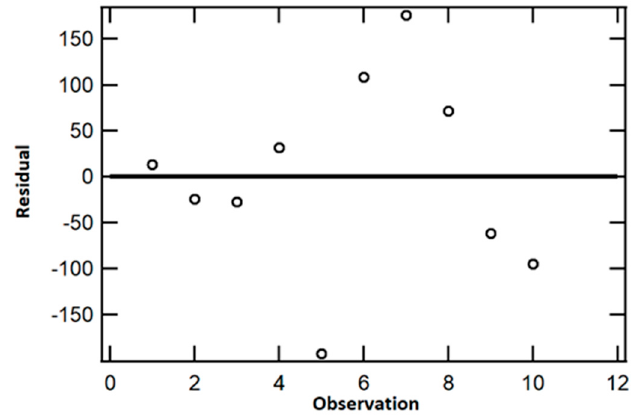
Figure 13. Residual plot confirms homoscedasticity assumption.